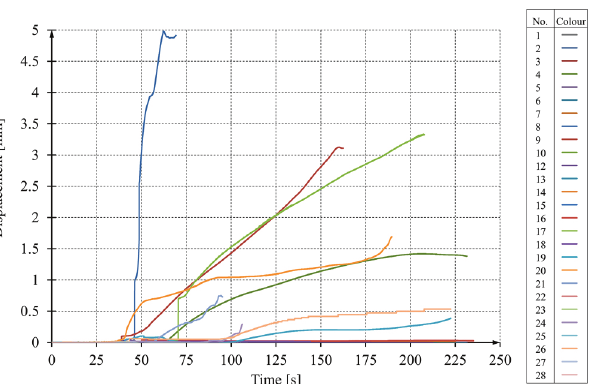
Fig. 11b. Changes of displacements measured on base C (Fig.